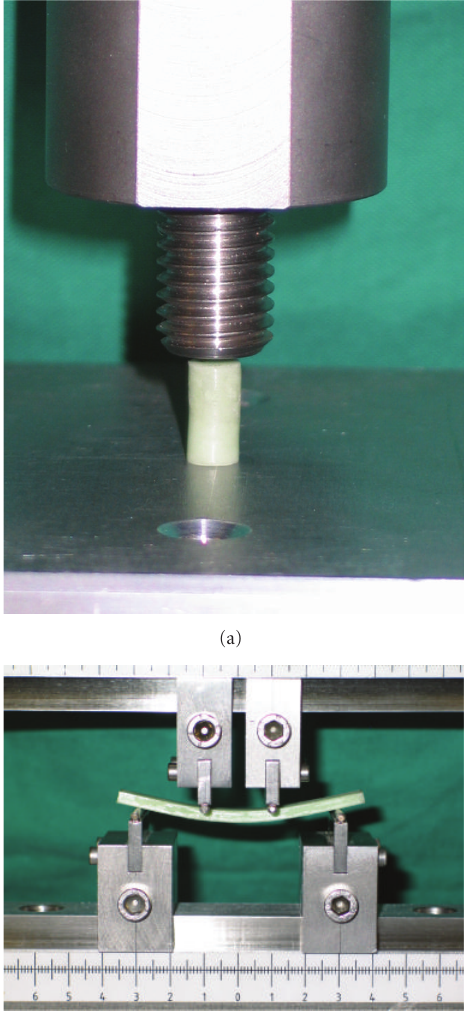
Figure 1: Test setup for (a) compressive strength testing and (b) bending modulus and bending strength testing stated by the ISO